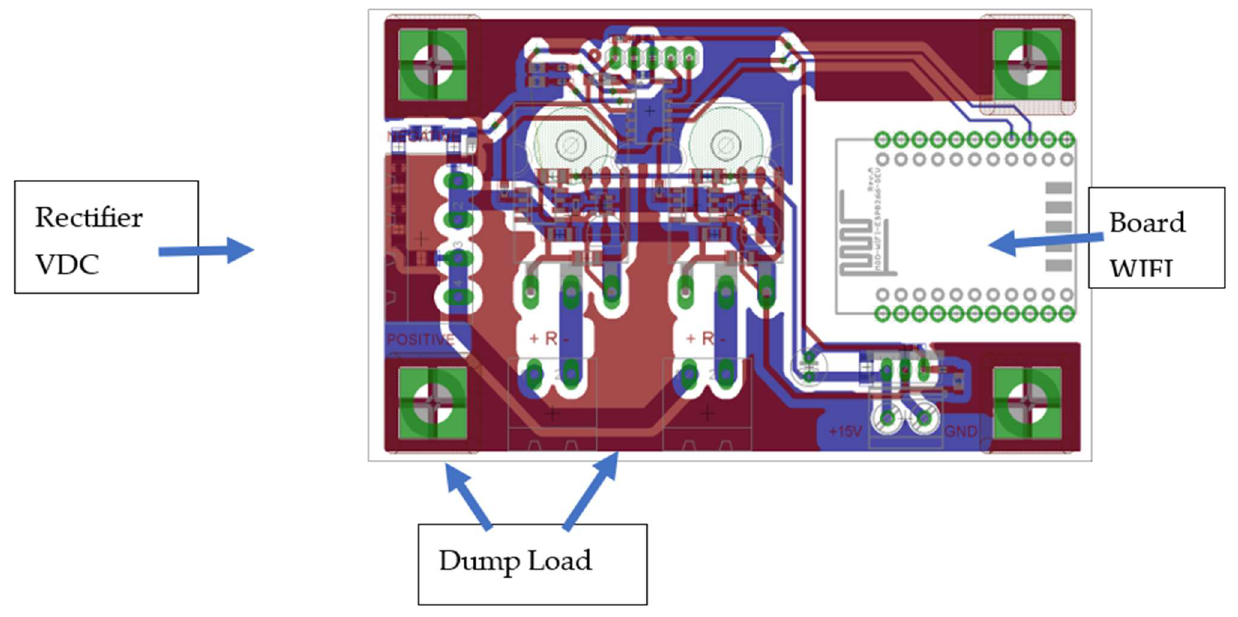
Figure 17. Schematic of the electronic board of the experimental prototype.